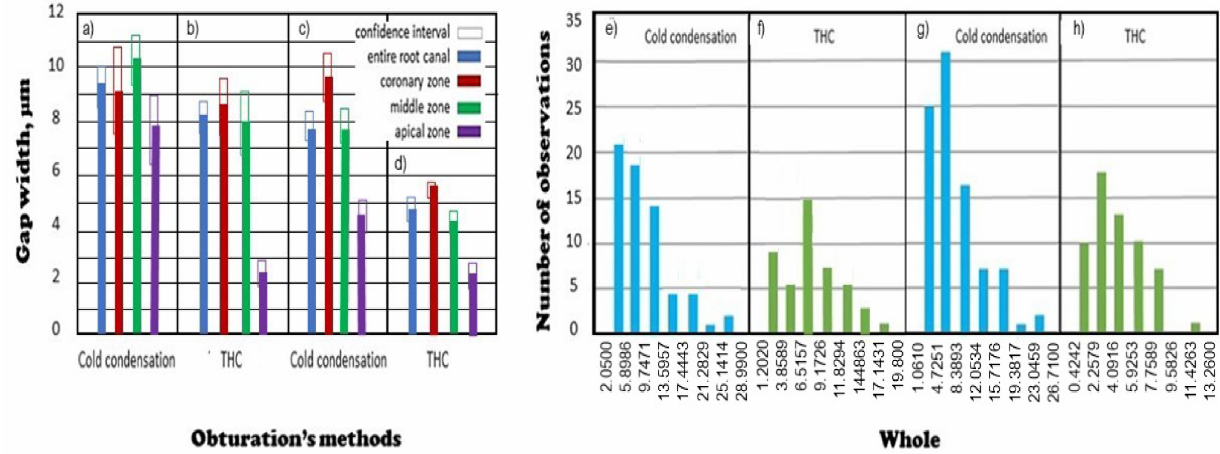
Figure 20. The results of the statistical evaluation of the results of the research on the width of the fissures as a whole and in the apical, medial and near-crown zones of the canals ( a – d ) and the histogram of the width of the fissures ( e – h ) as a result of filling the root canals with resilon ( a , b , e , f ) and comparatively with the material based on gutta-percha ( c , d , g , h ) by cold obturation ( a , c , e , g ) and thermoplastic condensation by Thermo-Hydraulic-Condensation THC technique ( b , d , f , h ).